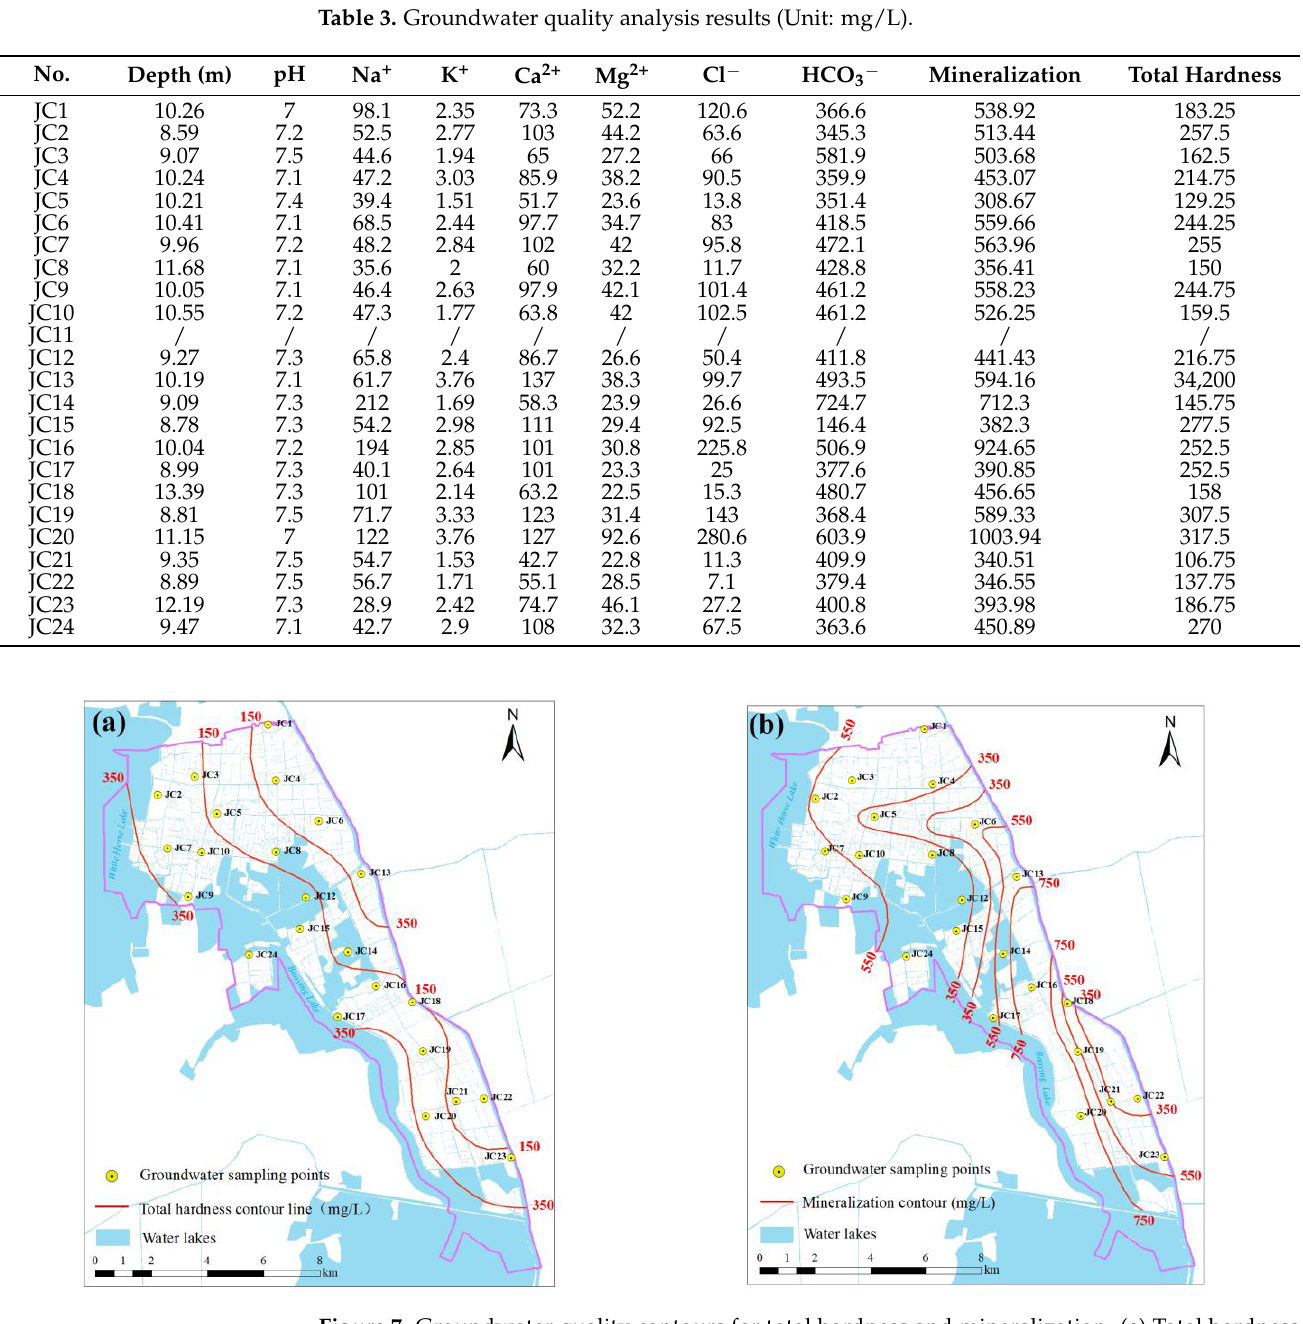
Figure 7. Groundwater quality contours for total hardness and mineralization. ( a ) Total hardness. ( b ) Mineralization. Table 3. Groundwater quality analysis results (Unit: mg/L).